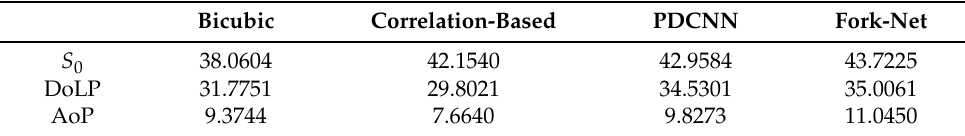
Table 1. The PSNRs for Different Methods on Test